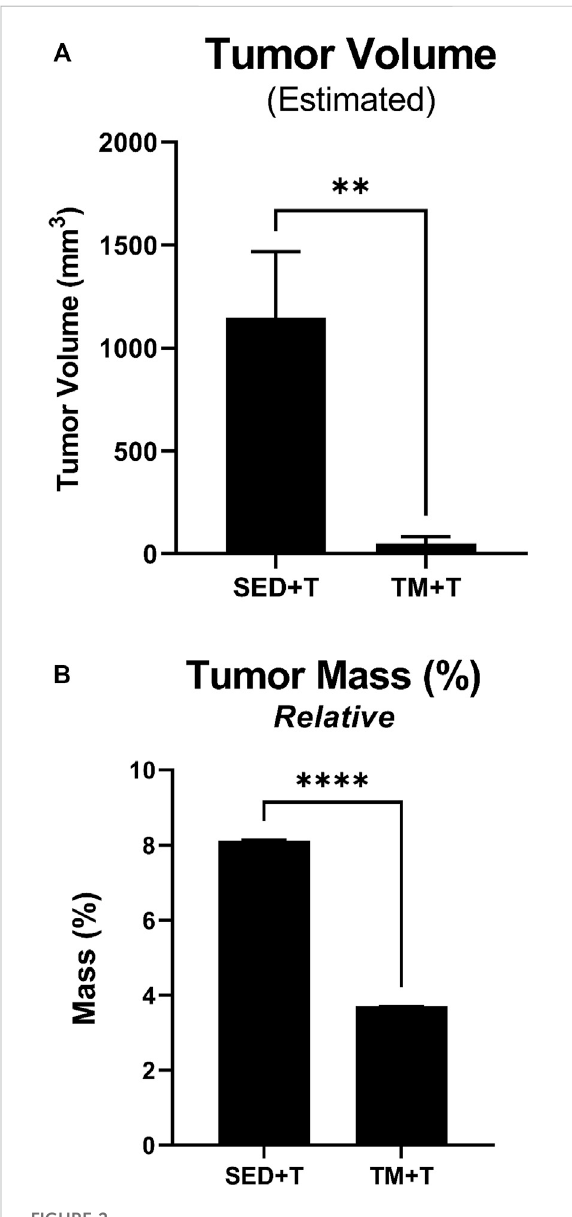
FIGURE 2 Tumor Mass and Volume. Preconditioning endurance exercise was associated with a signi fi cantly reduced estimated tumor volume (A) and relative tumor mass (B) based on length, width, and thickness tumor measurements. SED, sedentary; TM, preconditioning treadmill endurance exercise training; T, tumor bearing. Data are presented as mean ± SD. ** p < 0.01, **** p <